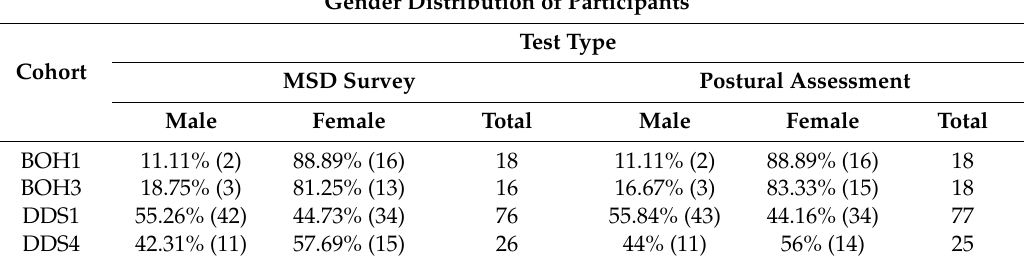
Table 2. Description of gender distribution and specific numbers of the cohorts that participated in the study.